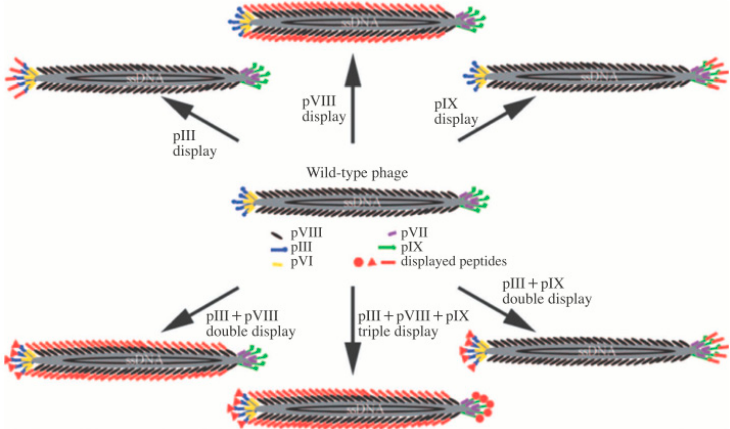
Figure 1. Basic structure of the M13 bacteriophage and the possible pathway of generic engineering. Reproduced from [9], with permission from WILEY-VCH, 2009.